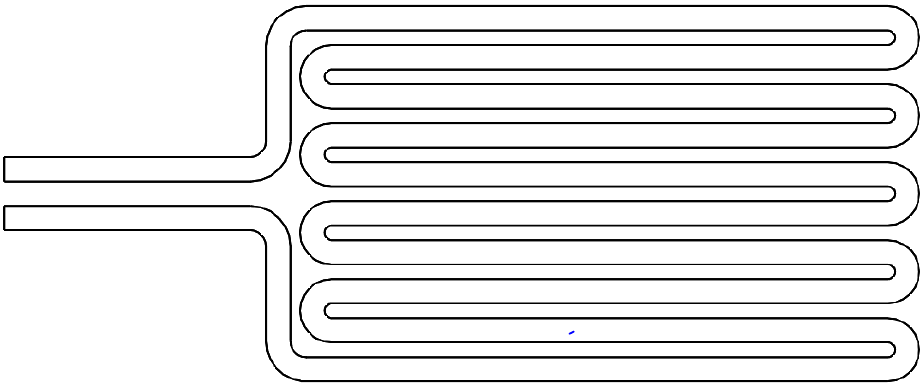
Figure A10. Fabric Design DP-3. Double pass design, woven conductive polyester fabric.